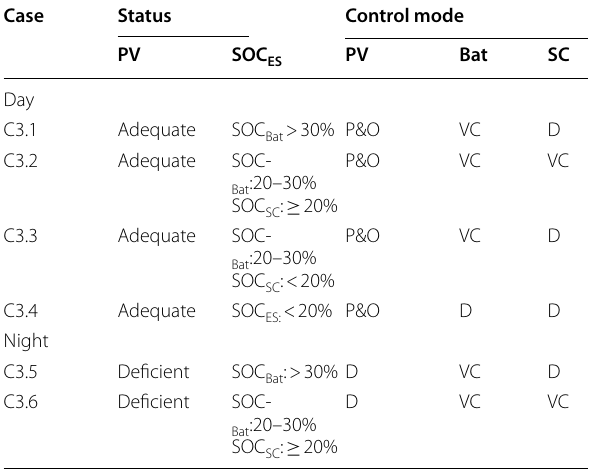
Table 3 Port state and control mode under constant power running condition